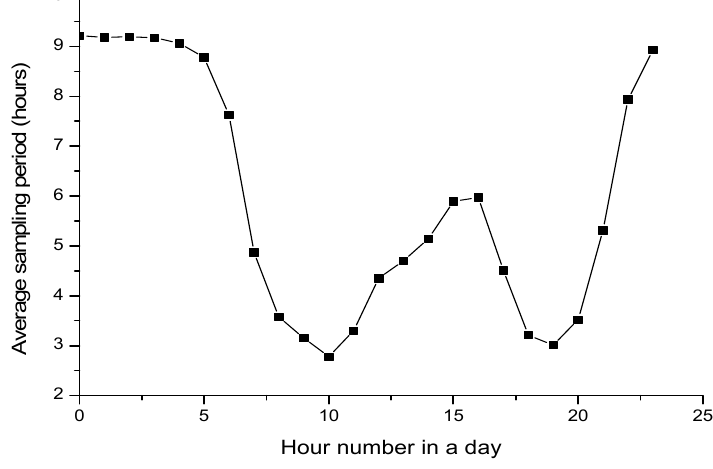
Figure 9. The average sampling period within different hour in a day.